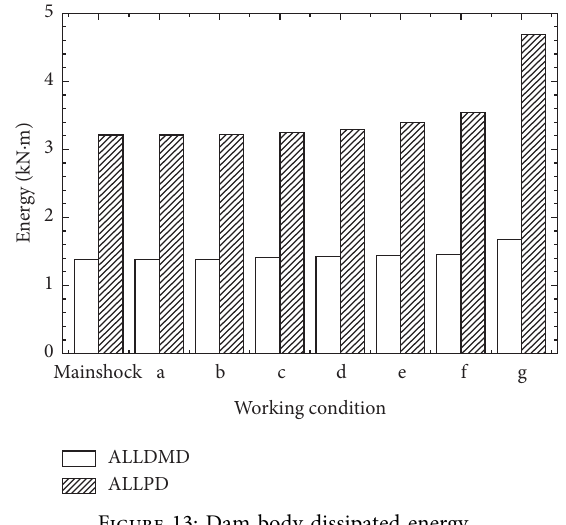
Figure 13: Dam body dissipated energy.